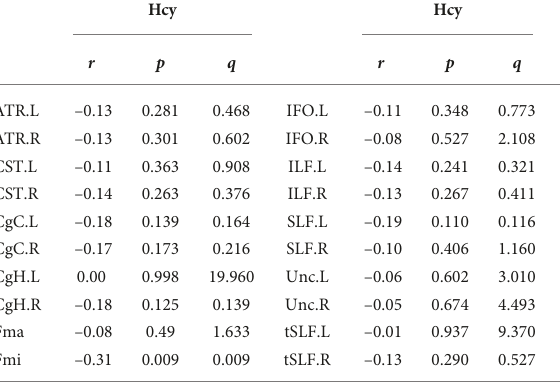
TABLE 1 Correlation of Hcy levels with FA values of WM tracts in patients with